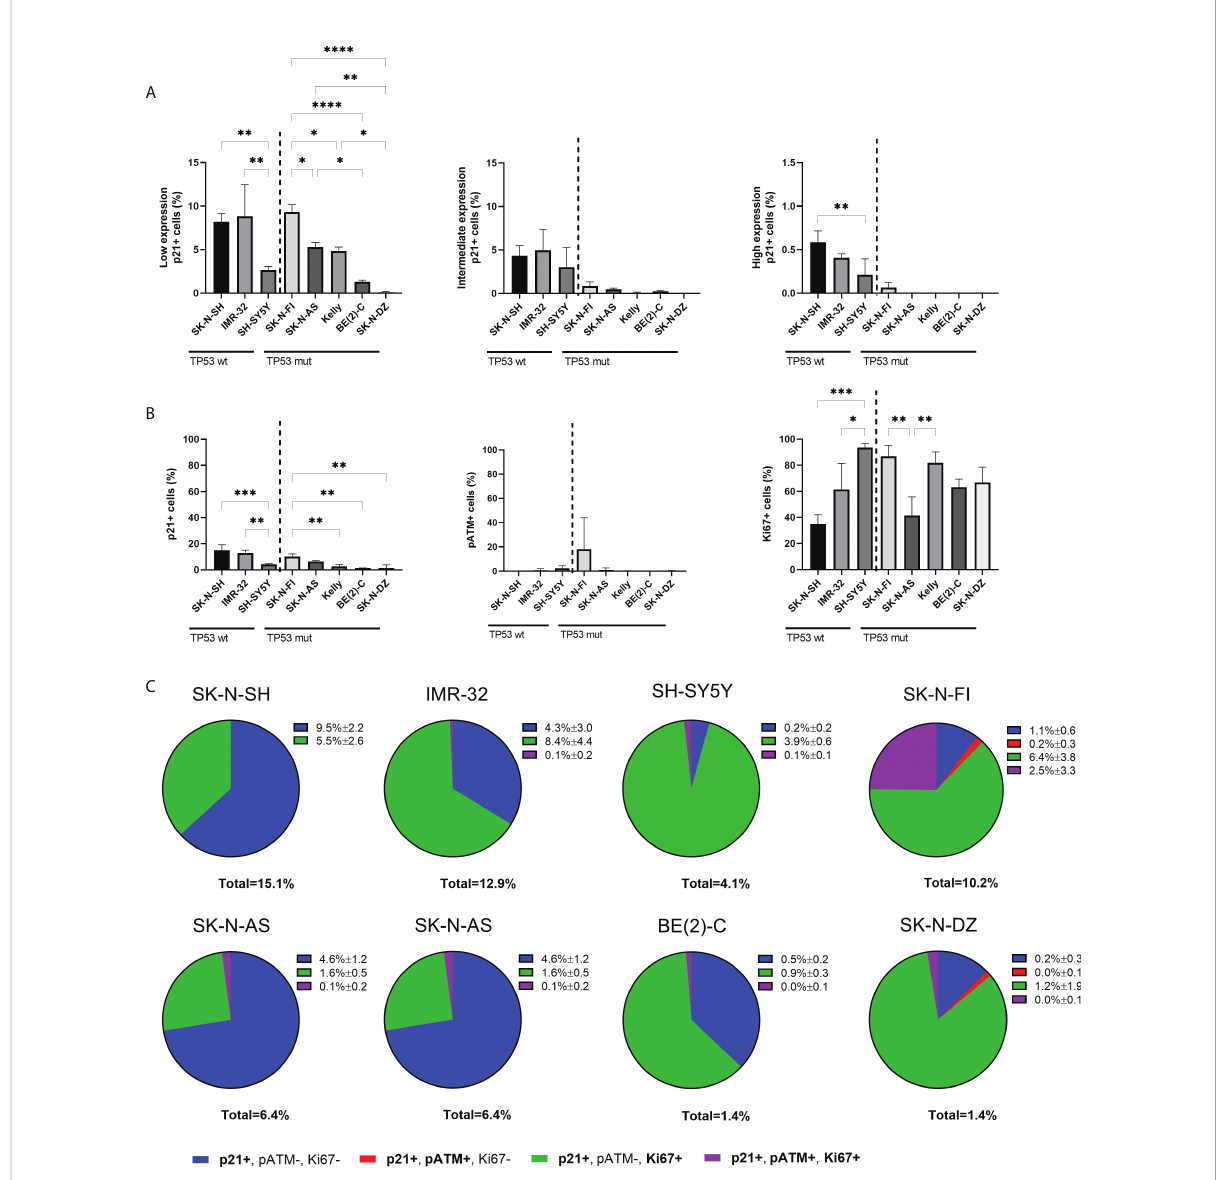
FIGURE 2 Expression levels of p21 and triple immuno fl uorescence staining with p21, pATM, and Ki67 in NB cell lines. (A) Graphs depict percentage of positive cells for low, intermediate, or high endogenous p21 expression. The TP53 wt cell lines showed cells with expression levels of p21 in all three ranges, whereas only SK-N-FI had expression levels of p21 in all three ranges among the TP53 mut cell lines. * = p<0.05, ** = p<0.01, **** = p<0.0001, not signi fi cant p>0.05. One-way ANOVA with Tukey post hoc test. Mean ± SD, n=3. (B) Analyzing the fraction of either p21, pATM or Ki67 single positive cells within all cell lines showed overall low fraction of cells positive for either p21 or pATM and a higher fraction of Ki67 expressing cells. * = p<0.05, ** = p<0.01, *** = p<0.001, not signi fi cant p>0.05. One-way ANOVA with Tukey post hoc test. Mean ± SD, n=3. (C) Pie charts of the four different combinations of p21 expressing cells within each cell line, either single p21 positive, p21 and pATM double positive cells, p21 and Ki67 double positive cells or p21, pATM, and Ki67 triple positive cells. The majority of cell lines showed that there are large subpopulations of replicating cells with p21 expression. Mean ± SD,